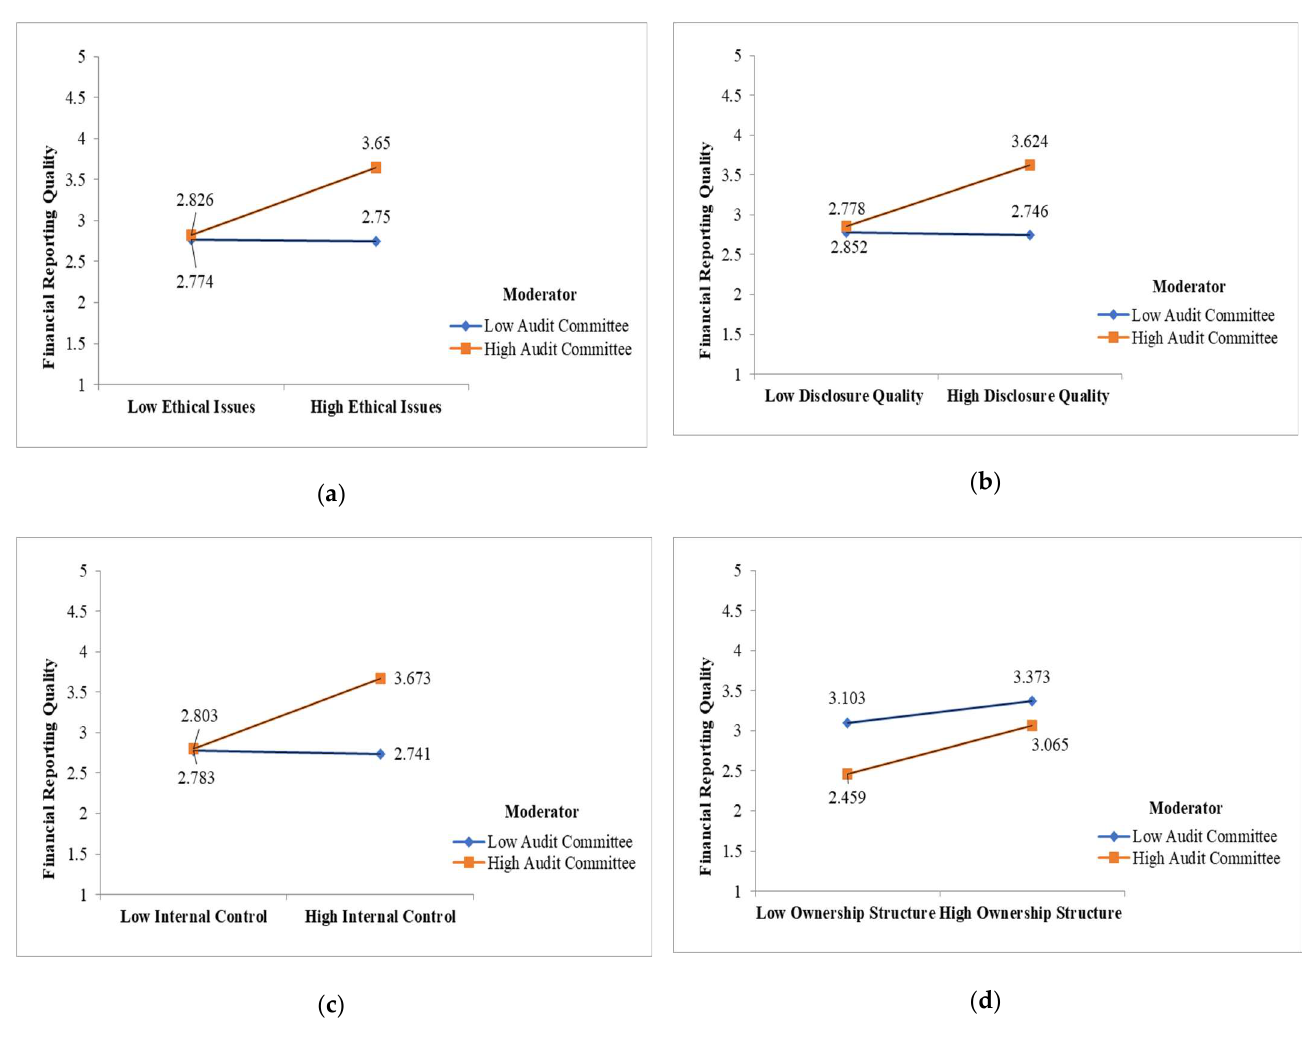
Figure 5. This figure is contained four graphs which are: ( a ) A two-way interaction of the AC on the EI and FRQ; ( b ) A two-way interaction of the AC on the DQ and FRQ; ( c ) A two-way interaction of the AC on the IC and FRQ; ( d ) A two-way interaction of the AC on the OS and FRQ.